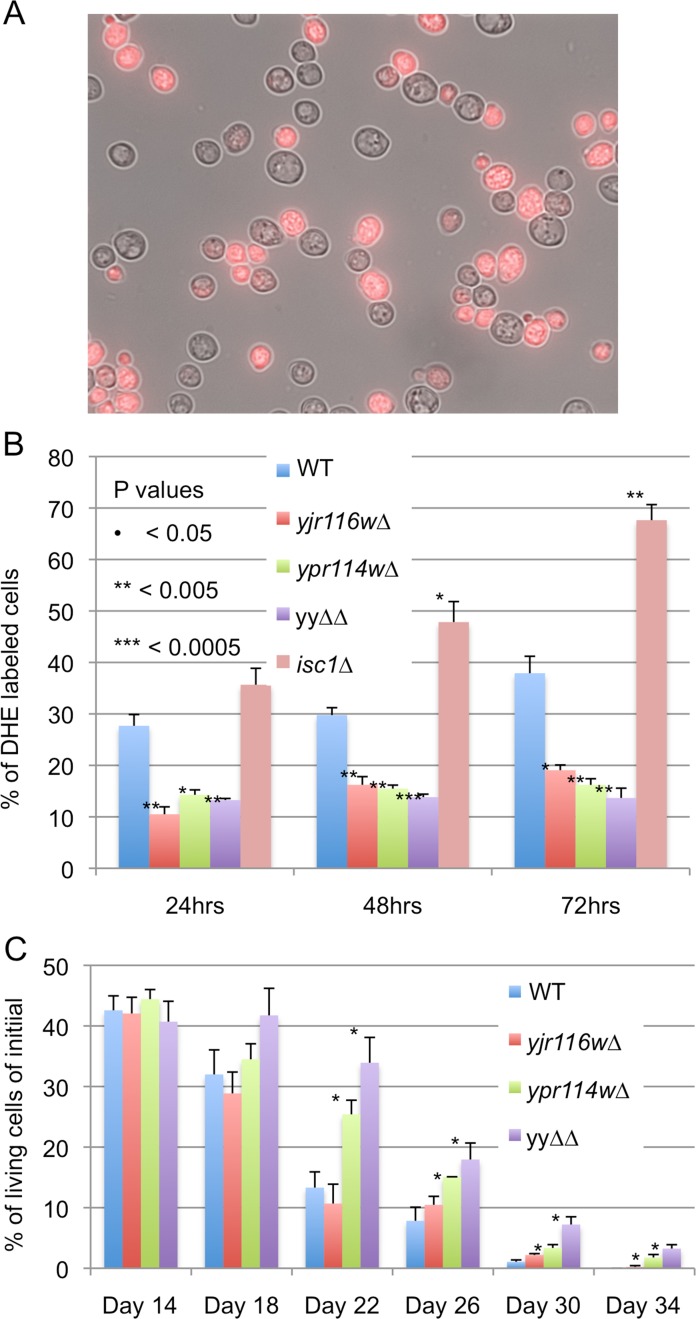
Yjr116w∆ and ypr114w∆ make lower amounts of superoxide anions in stationary phase than WT and have an increased CLS.A. Cells were stained with DHE for measurement of superoxide anion levels. Fluorescence and transillumination pictures were merged to illustrate the difference between positive and negative cells. B. Percentages of DHE positive cells amongst 200 cells were determined in three independent experiments and the difference between mutants and WT in the same condition was evaluated by student’s t-test with P< 0.05 = *, P< 0.005 = **. C. The chronological life spans were determined in diploid deletion strains by measuring the colony-forming units after different periods in water (see Materials and Methods). Data represent three biological replicates using different clones and the differences between mutants and WT were evaluated as above.